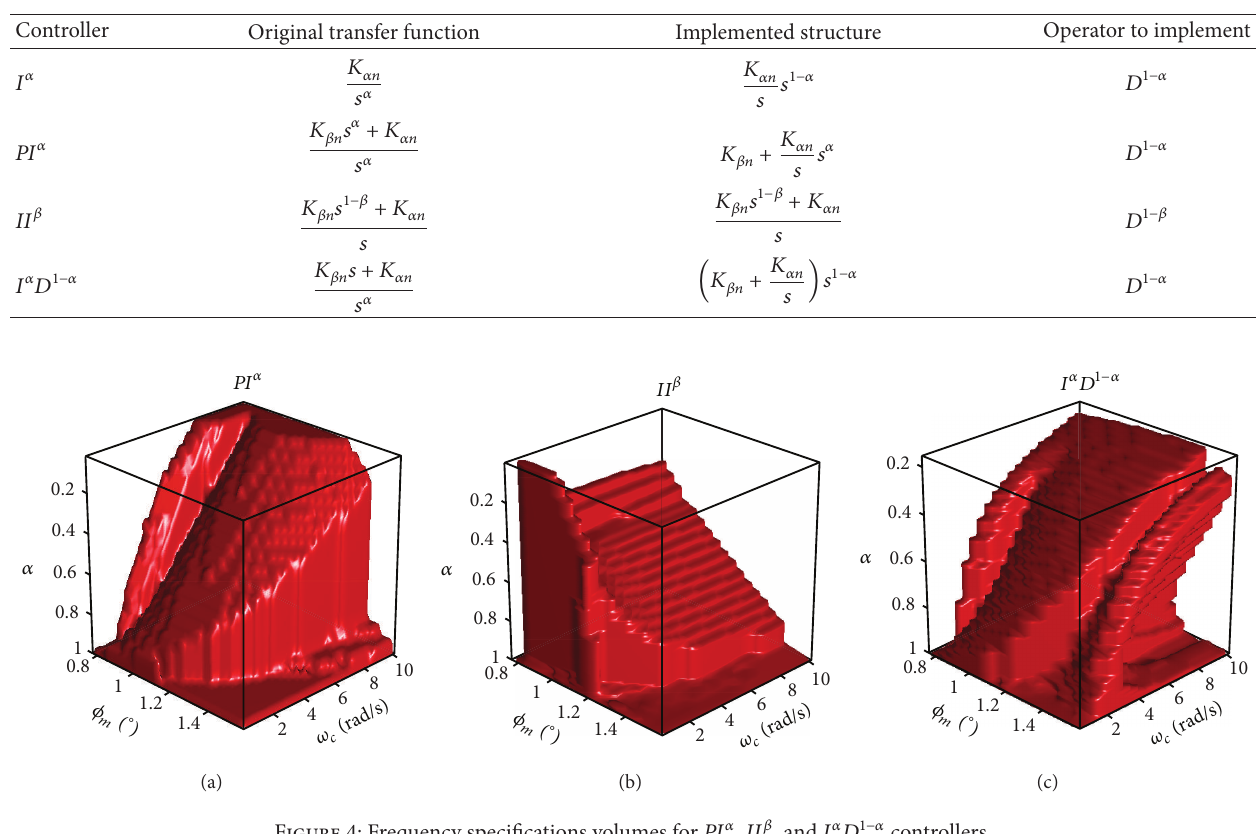
Figure 4: Frequency specifications volumes for 𝑃𝐼 𝛼 , 𝐼𝐼 𝛽 , and 𝐼 𝛼 𝐷 1−𝛼